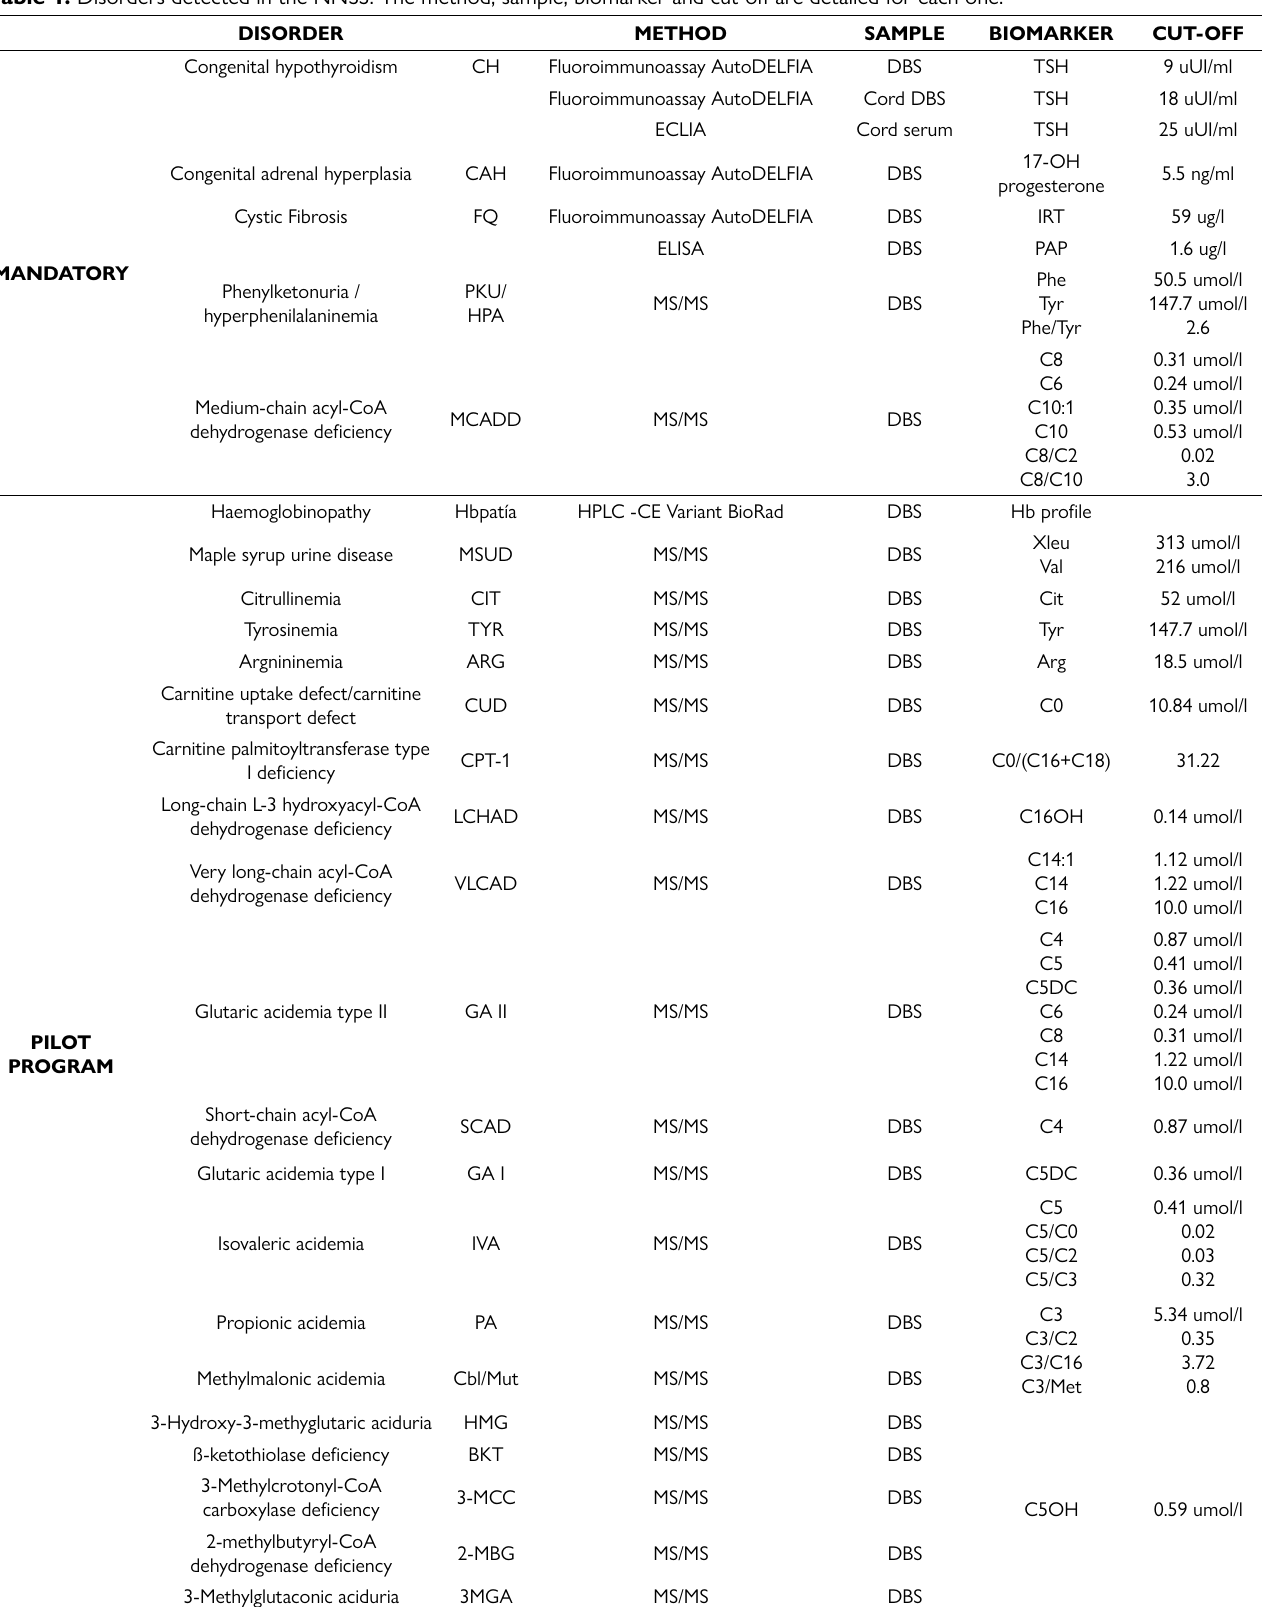
Table 1. Disorders detected in the NNSS. The method, sample, biomarker and cut-off are detailed for each